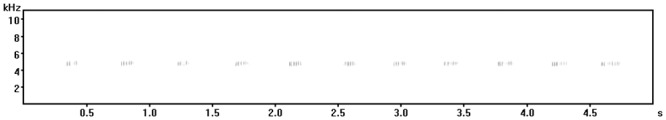
Spectrogram of calls series of Liuixalus jinxiuensis sp. nov.The recording was high-pass filtered (above 5.5 kHz) to avoid high-frequence noise. Calls for figure spectrogram were created using 22005 Hz sampling frequency. Figure spectrogram was created using Hamming window, FFT-length 512 points, frame 100%, and overlap 75%.